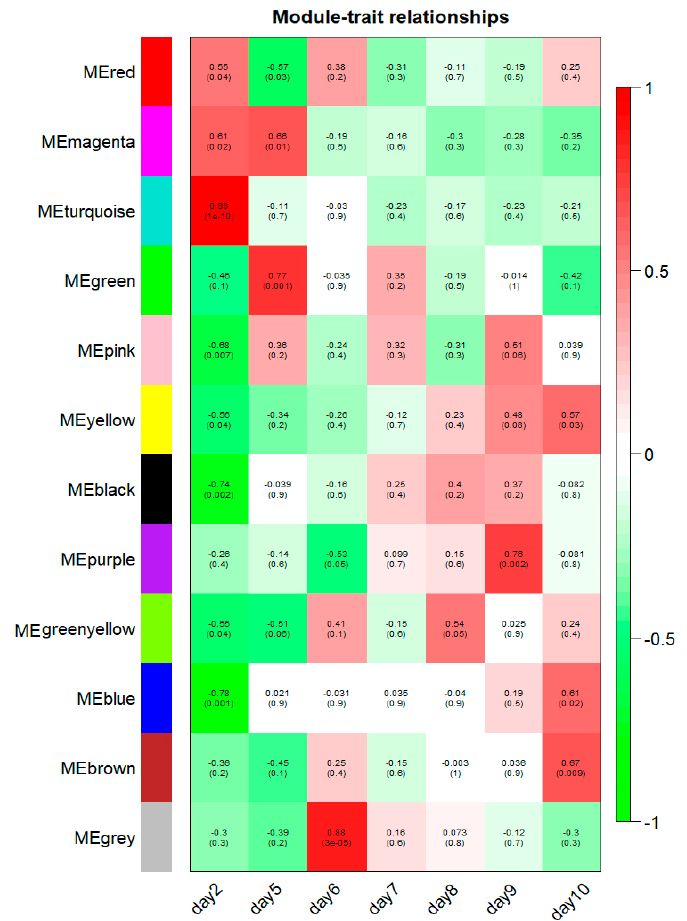
Figure 7. Module-stage relationships (MSRs) in channel catfish, Ictalurus punctatus . Each row corresponds to a module, and each column represents a specific development stage. The right color panel represent Pearson’s r correlation coefficient. The MSRs are colored based on the correlation coefficient between the module and the developmental stages. The Pearson’s r correlation coefficients and associated p -values are given in each cell. For better resolution of this figure, the readers are referred to the online version of this figure.